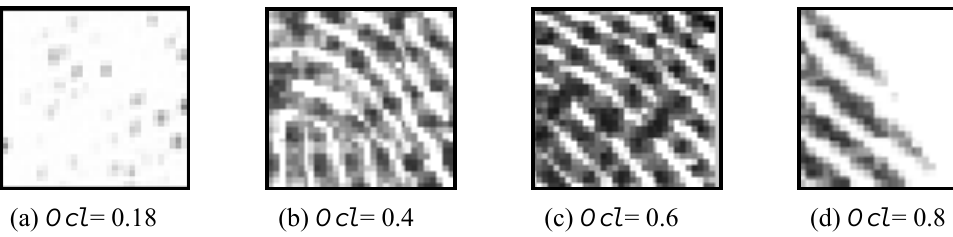
Figure 3. Fingerprint blocks with variable orientation